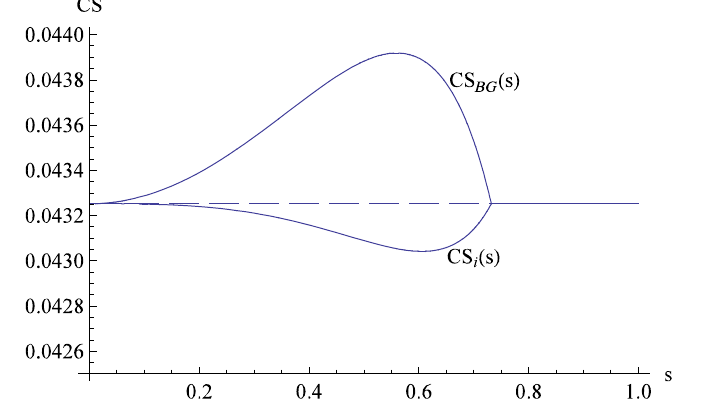
Fig. 5 Consumer surplus for buyer group members, CS BG ( s ), and non-members, CS i ( s ), as a function of the buyer group size, when the seller utilizes a KAM program. Parameter values: z (cid:4)